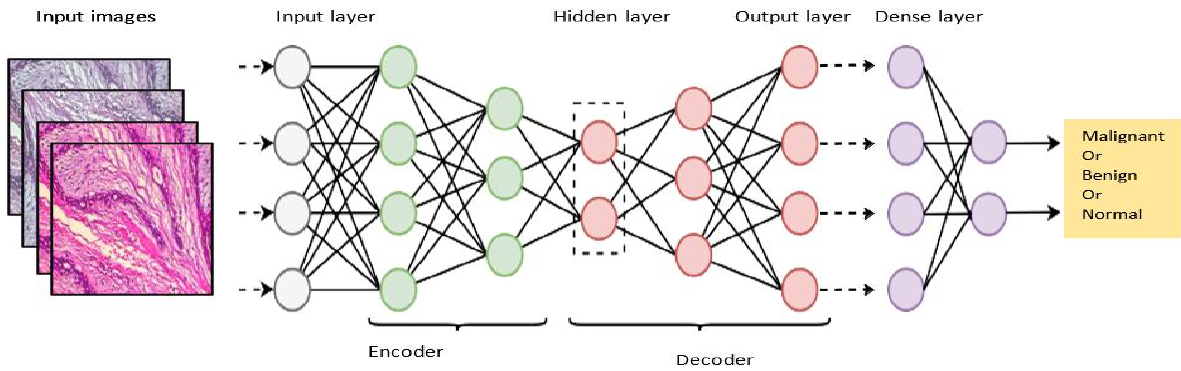
Figure 2. An illustration of the deep autoencoder.